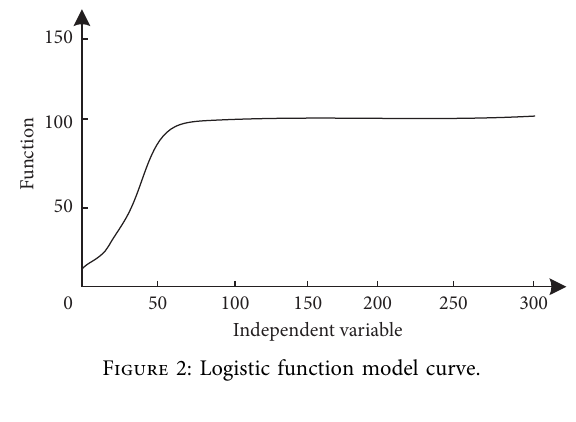
Figure 2: Logistic function model